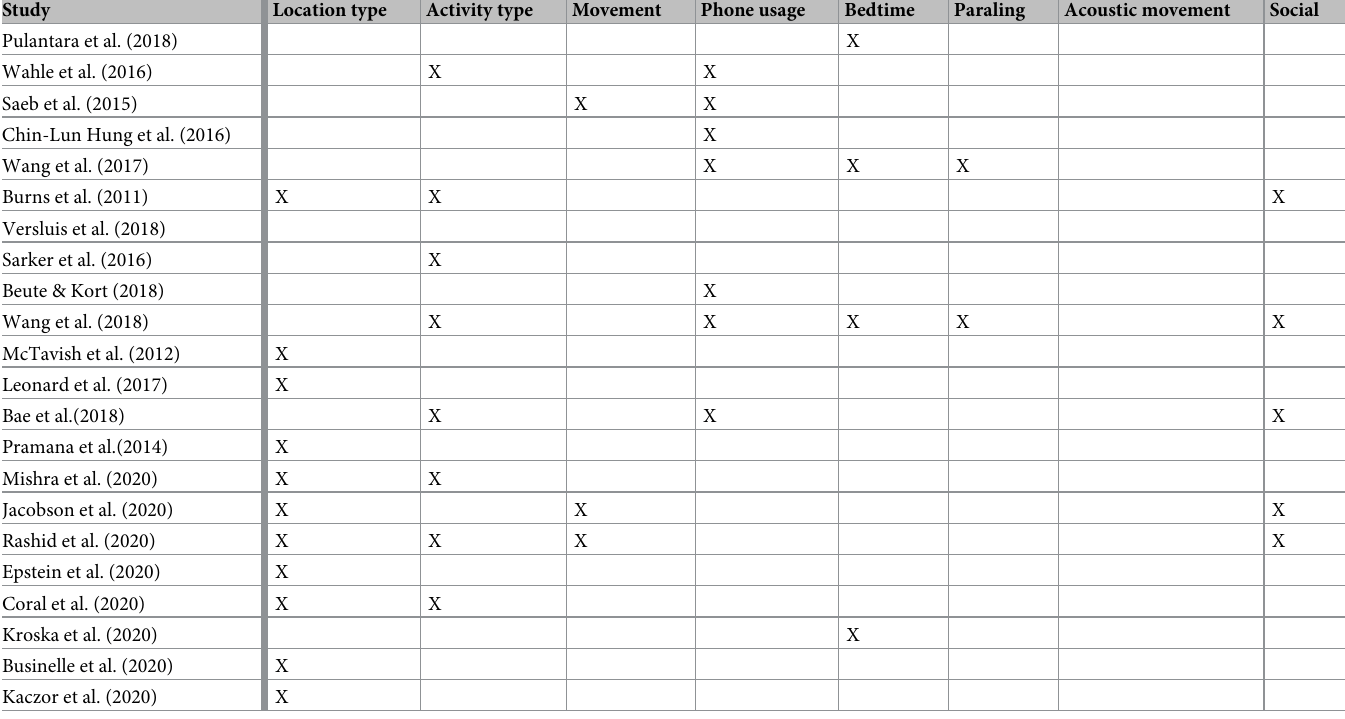
Table 4. Features derived from data collected from